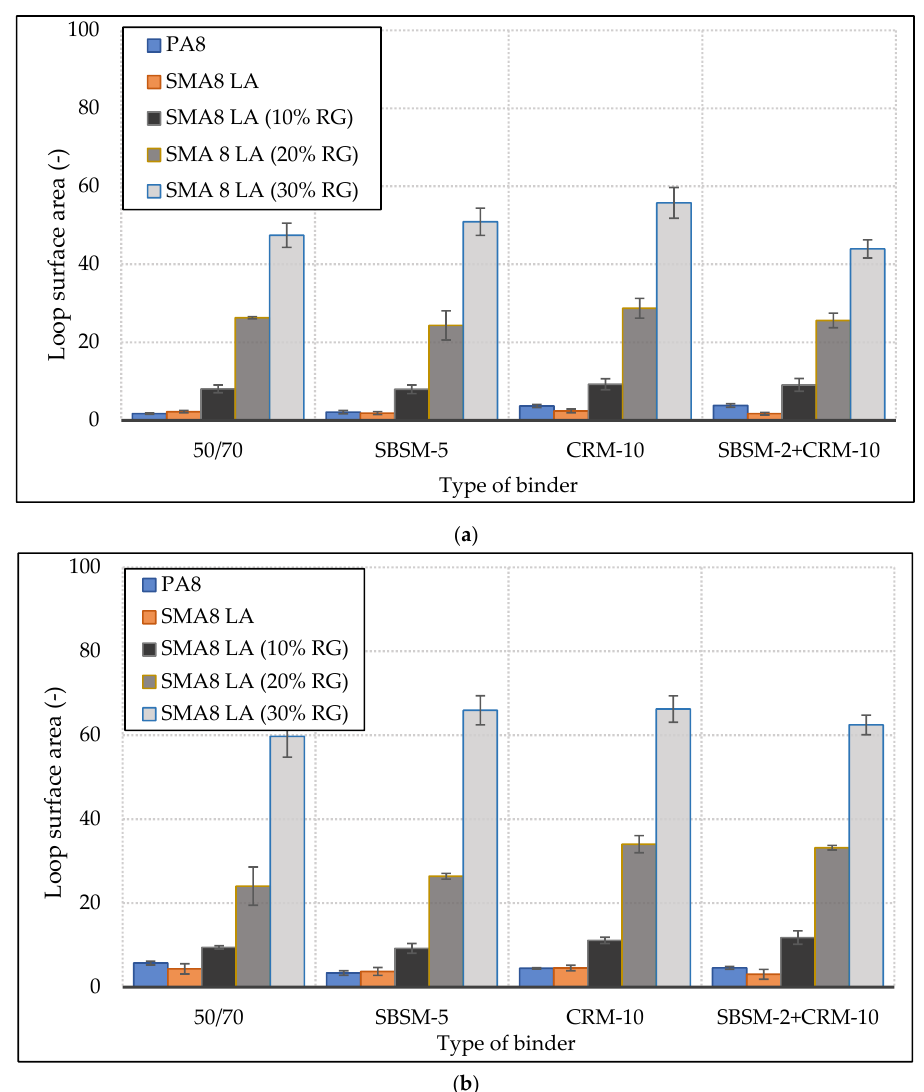
Figure 8. Elastic hysteresis loops of SMA8 LA (20% RG) mixture with: ( a ) bitumen 50 / 70, ( b ) modified bitumen 50 / 70 SBSM-5, ( c ) modified bitumen 50 / 70 CRM-10, ( d ) modified bitumen 50 / 70 SBSM-2 + CRM-10.